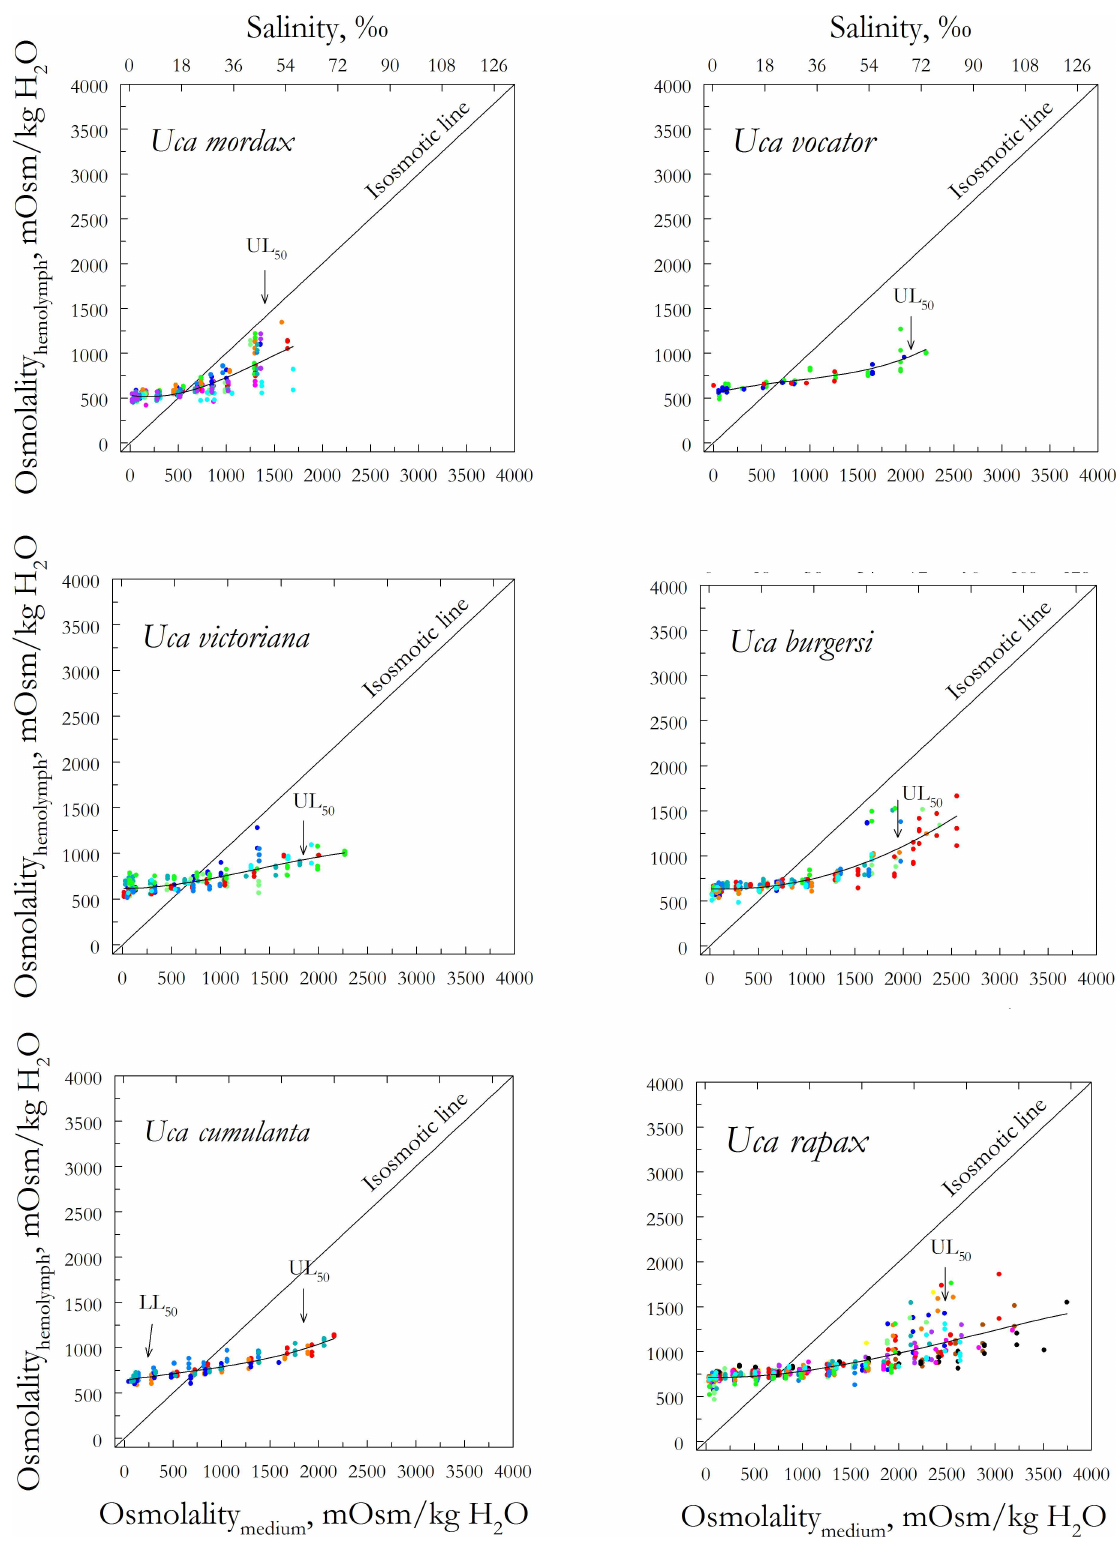
Fig 1. Hemolymph osmoregulatory capability in six Uca species. Speciesare color-codedby populationorderedon habitat salinity, after 5-days direct transfer from collectingsite water to each different salinity. Populationsof each species were